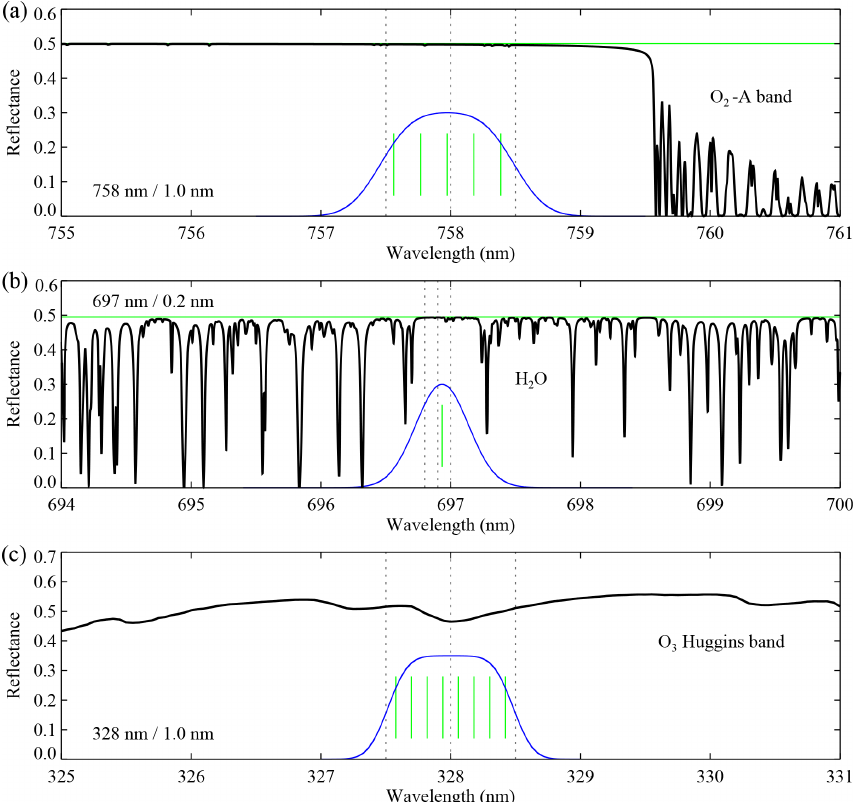
Figure 5. Simulated reflectance spectra (in black) relevant to the wavelength bands at 758, 697, and 328nm. Panel (a) shows the very small impact of oxygen absorption near 758nm, while (b) shows the larger impact of water vapour absorption around 697nm. Panel (c) presents the situation of ozone absorption near 328nm. For comparison, the horizontal green curves indicate reflectance spectra simulated without absorption by oxygen and water vapour. The vertical green lines indicate the spectral positions of the detector pixels that make up the wavelength bands (see Table 1). The blue curves indicate the response functions of the wavelength bands based on the indicated detector pixels and their individual slit